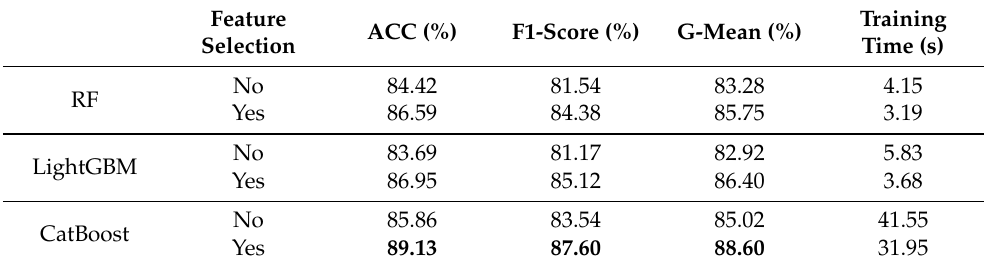
Table 4. The result of ablation